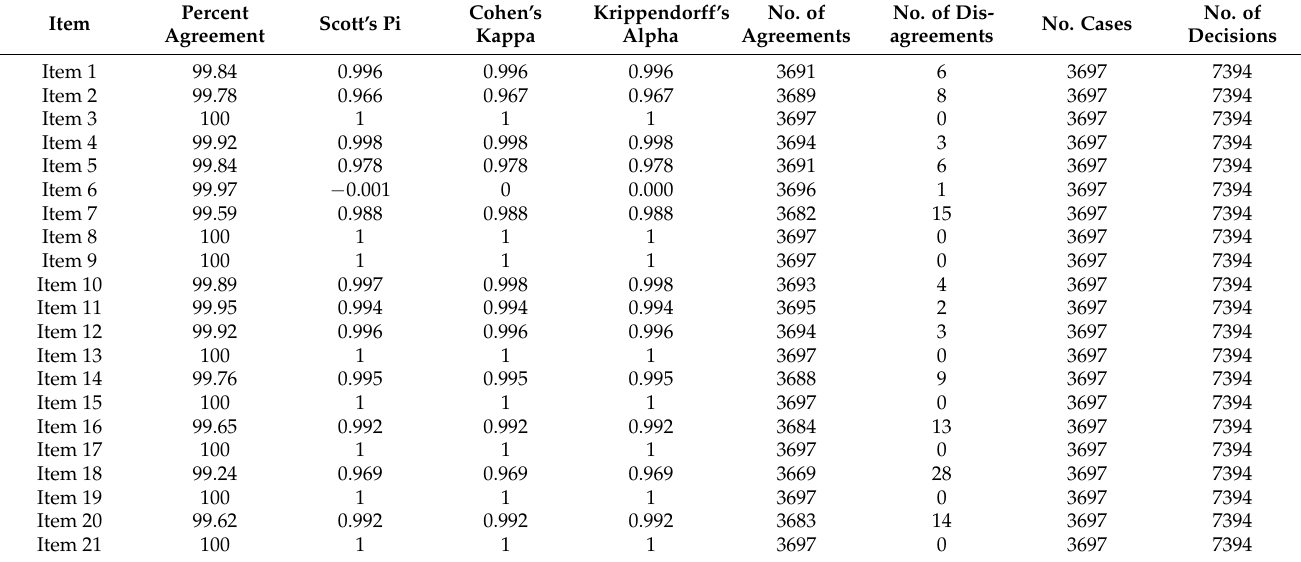
Table 2. Inter-rater reliability measures for the items of the Matrix Determinant of Vaccine